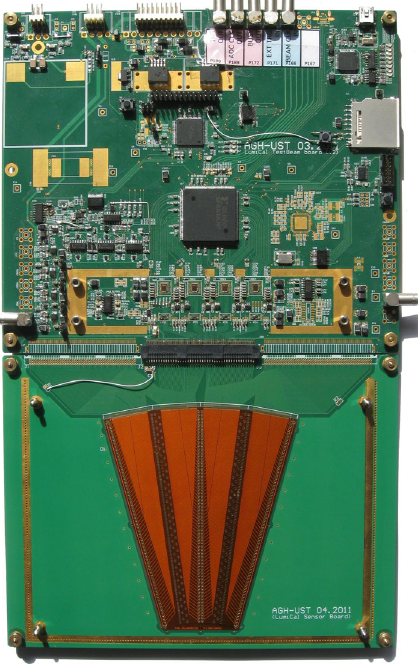
Fig. 6 Photograph of a LumiCal readout module attached to a sensor